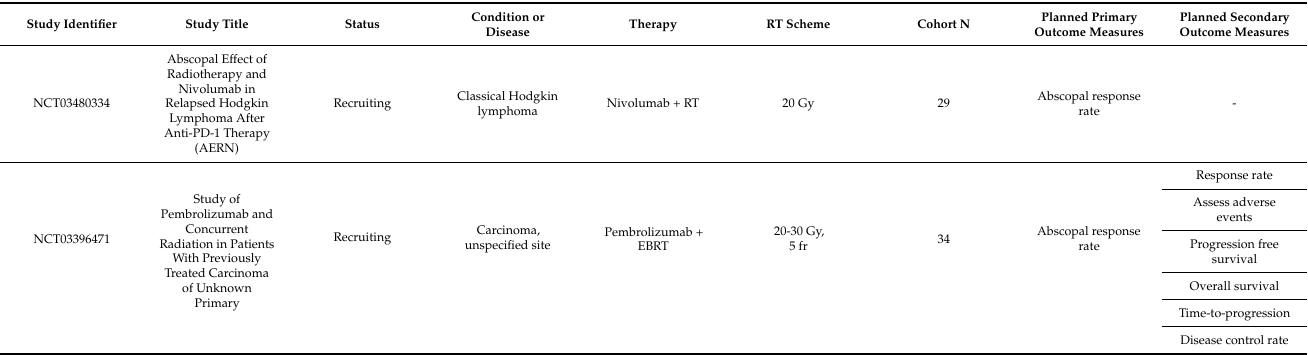
Table 5. Currently ongoing clinical